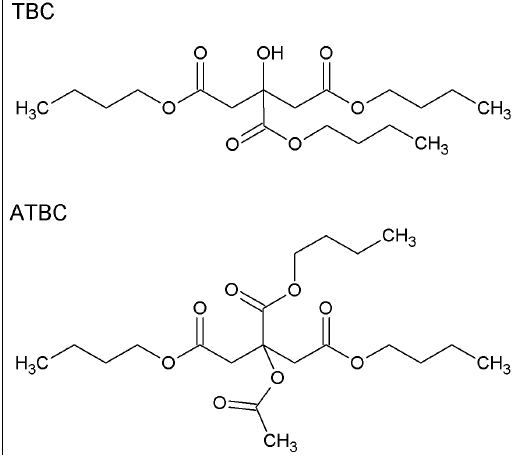
Figure 3. Chemical structure of tributyl citrate (TBC) and tributylacetyl citrate (ATBC).